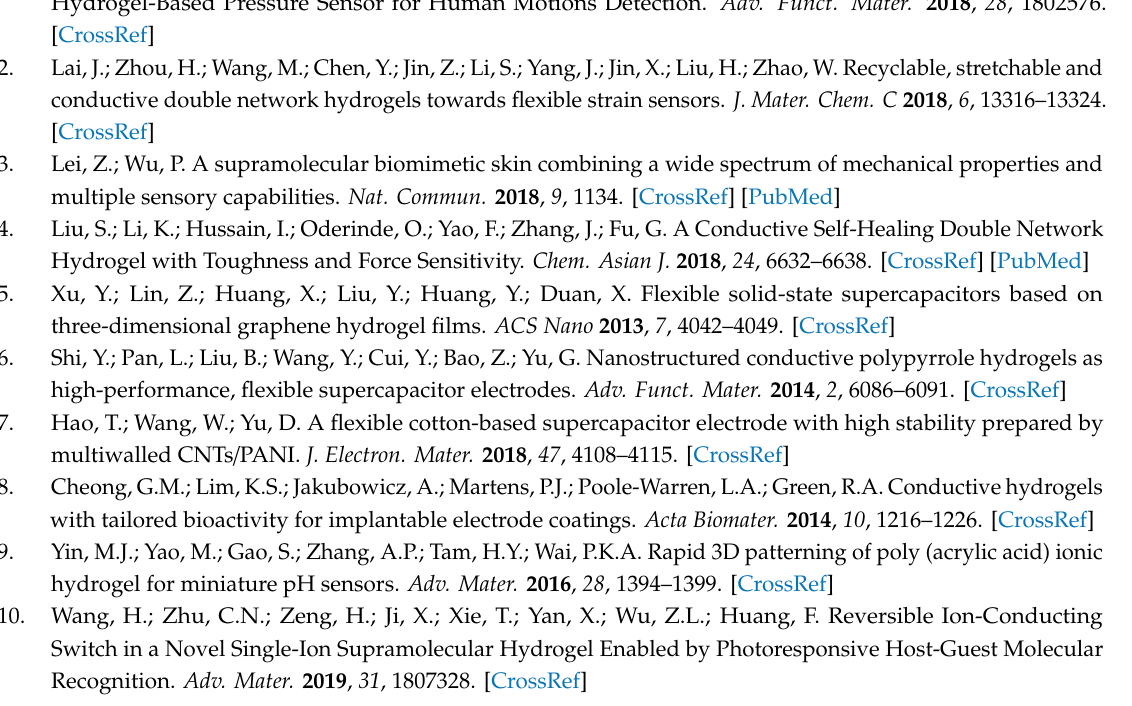
Figure S1: FT-IR spectra of PNIPAM / PANI hydrogels (black) and PNIPAM hydrogels(red)., Figure S2: SEM images of PNIPAM hydrogels (a) and PNIPAM / PANI hydrogels (b). Figure S3: (a) The diameter of the hydrogels vary under increasing temperature from 2 to 50 ◦ C. (b) The temperature-dependent conducting properties for PNIPAM / PANI hydrogels. Figure S4: The geometry for the electrodes by di ff erent motions. Figure S5: Real-time monitoring of relative resistance changes. Figure S6: Using temperature responsive conductive hydrogels to prepare YES gate. Figure S7: The size of the logic gates(The unit is cm). Figure S8: The swelling ratios of the hydrogels. (a) The pH-responsive conductive hydrogel. D 0 represents the diameter of the hydrogel at pH 2, and ∆ D represents the di ff erence between the diameter of the other pH and D 0 . (b) The thermo-responsive conductive hydrogels. D 0 represents the diameter of the hydrogel at 50 ◦ C, and ∆ D represents the di ff erence between the diameter of the other temperature and D